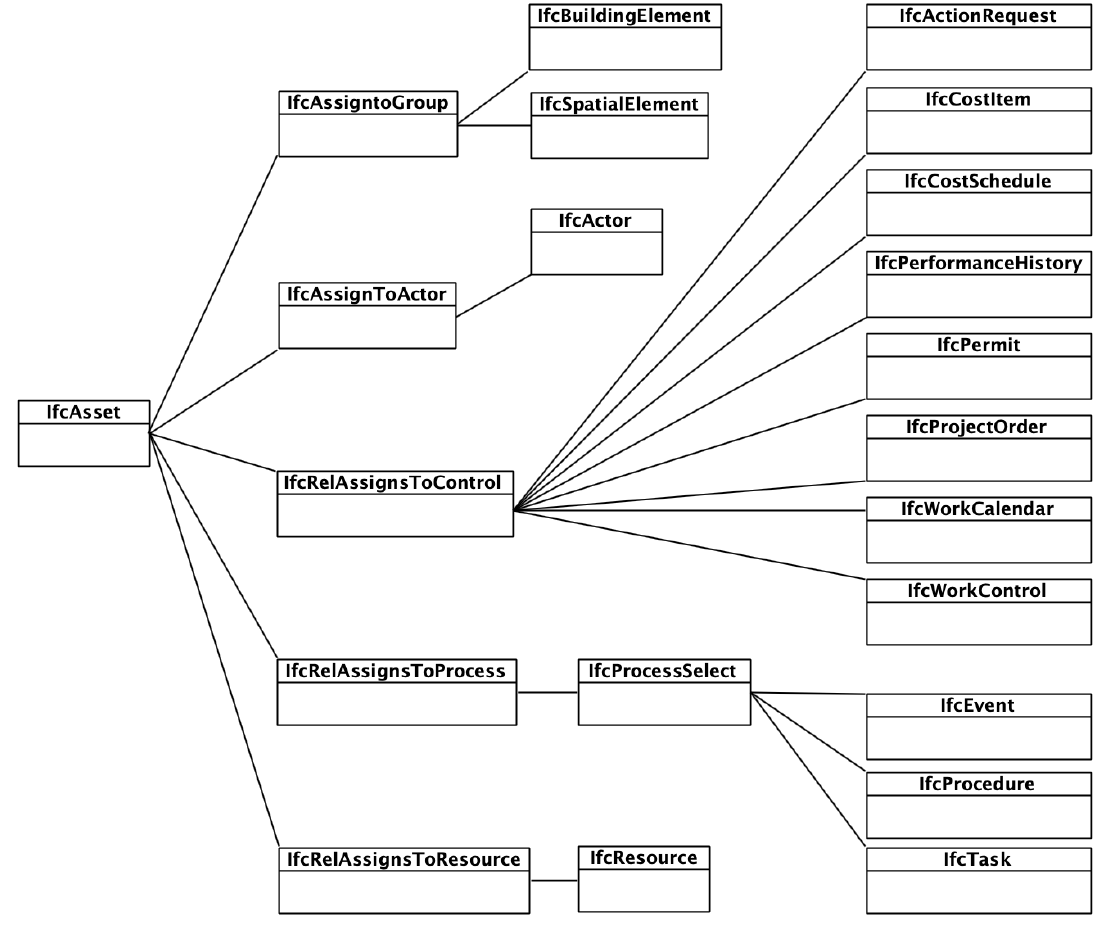
Figure 1. IfcAsset